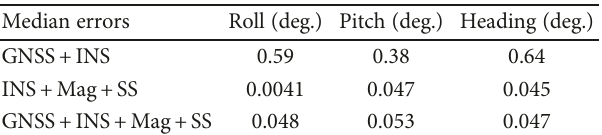
Figure 5: Comparison between GPS-only mode and GPS + GLONASS mode for all pro fi les, latitude shown. Table 4: Unscented Kalman fi lter error statistics: median attitude error.